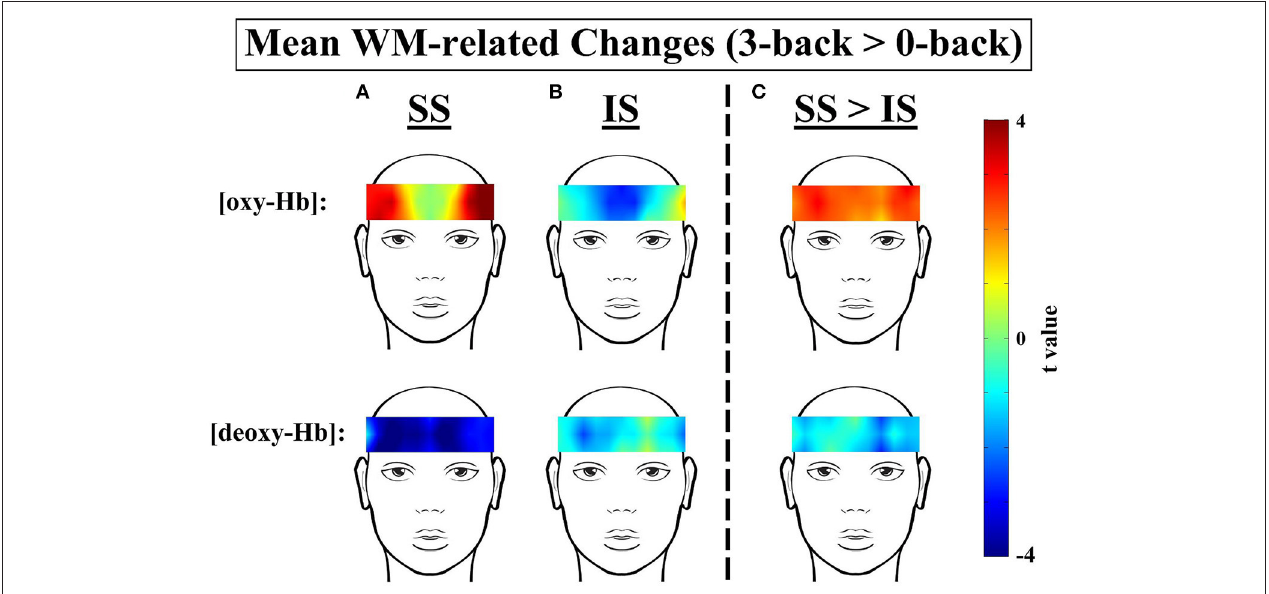
FIGURE 5 | t -Contrast maps of the mean working-memory-related (WM-related, i.e., 3-back > 0-back) [oxy-Hb] and [deoxy-Hb] changes in the (A) Sufficient Sleep (SS; n = 20) and (B) Insufficient Sleep (IS; n = 20) groups and (C) between the SS and IS groups. For the top panels of (A,B) , red and blue indicate WM-related [oxy-Hb] increases and decreases, respectively; for the bottom panels of (A,B) , red and blue indicate WM-related [deoxy-Hb] increases and decreases, respectively. In addition, for the top panel of (C) , red indicates greater WM-related [oxy-Hb] increases in the SS group; for the bottom panel of (C) , blue indicates greater WM-related [deoxy-Hb] decreases in the SS